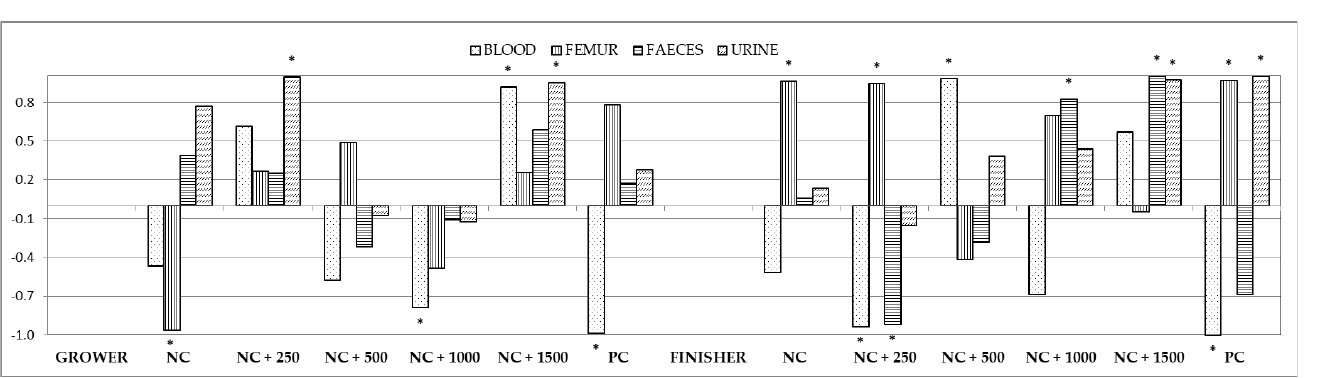
Figure 1. Correlations between content of phosphorus in the chyme and in the blood, femur, feces, and urine. Asterisks indicate significant correlations at p < 0.05. and urine. Asterisks indicate significant correlations at p < 0.05.